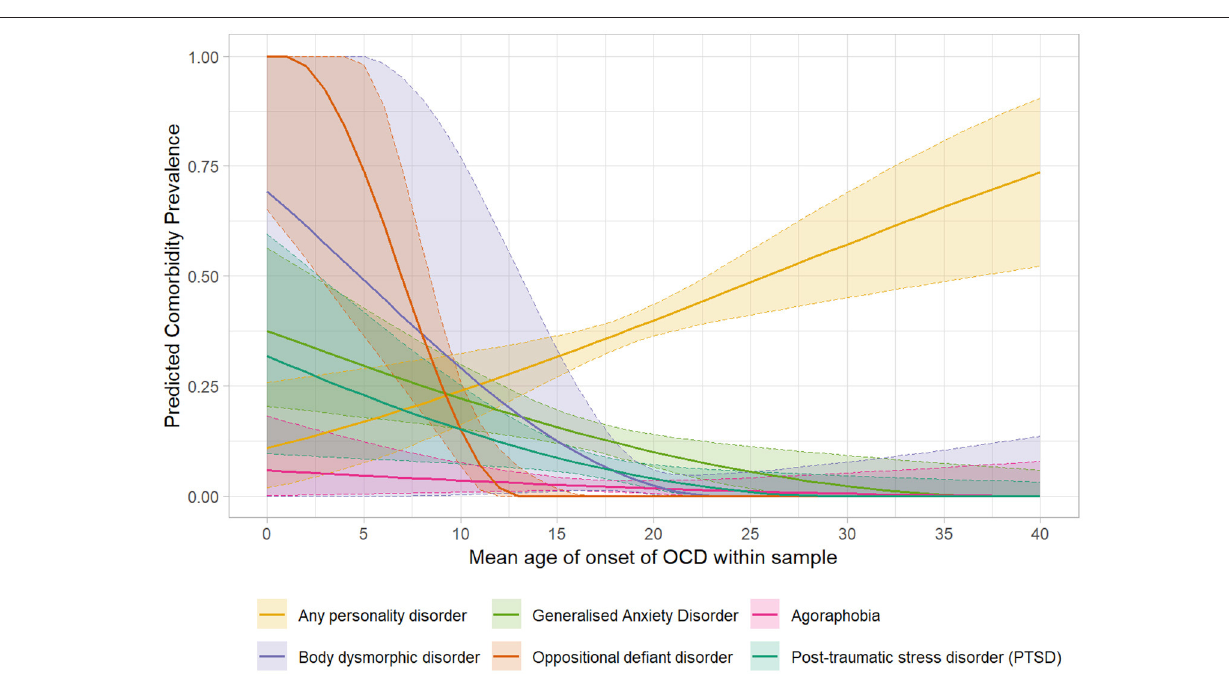
FIGURE 5 | Significant meta-regressions by mean age of onset of samples. Rates of GAD, Agoraphobia, ODD, PTSD & BDD are higher in samples with earlier mean age of onset, while rates of Personality Disorders are higher in samples with later age of onset. with OCD. The meta-analysed studies were clinic-based and reported original findings on individuals with OCD, evaluated using standardised diagnostic